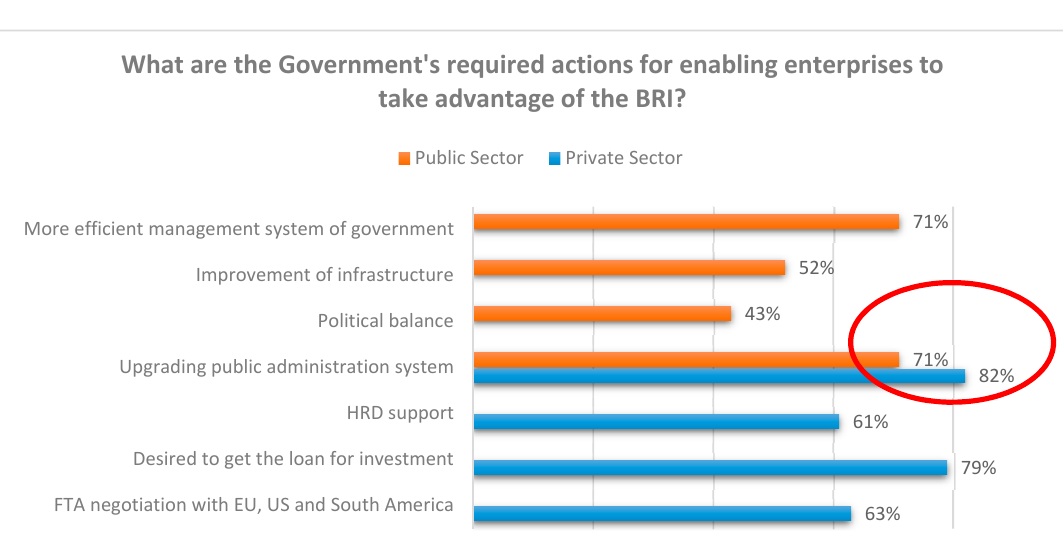
Figure 8. Improving the existing public administration system becomes crucial (Source: Authors’ analysis).